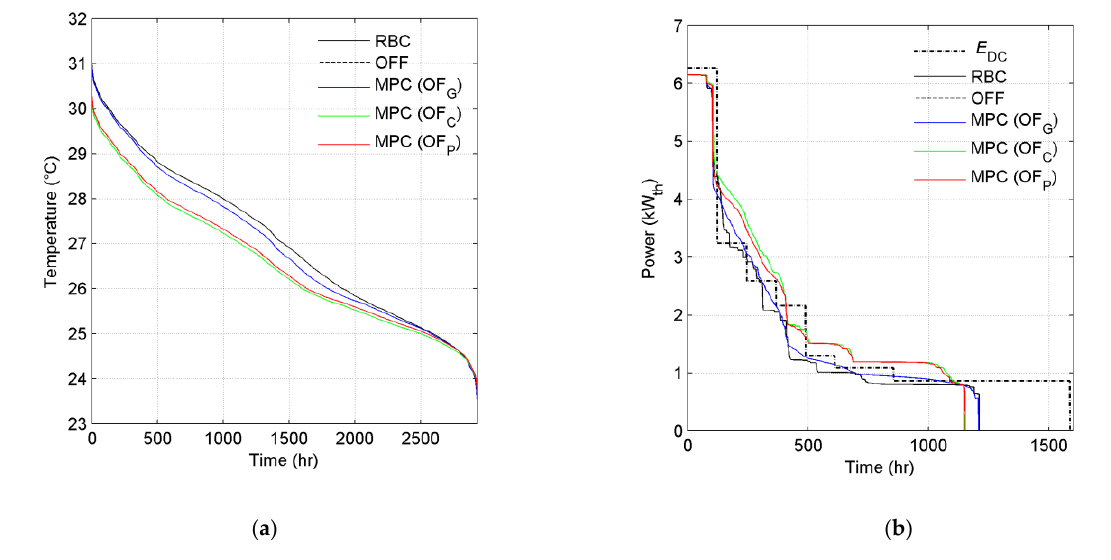
Figure 22. Duration curve for ( a ) the indoor air temperature and ( b ) cooling power from DC used by the neighboring building. Comparison between RBC, MPC with OF G , OF C and OF P ( PH = 18 h) and user disconnection from the DC network (OFF).